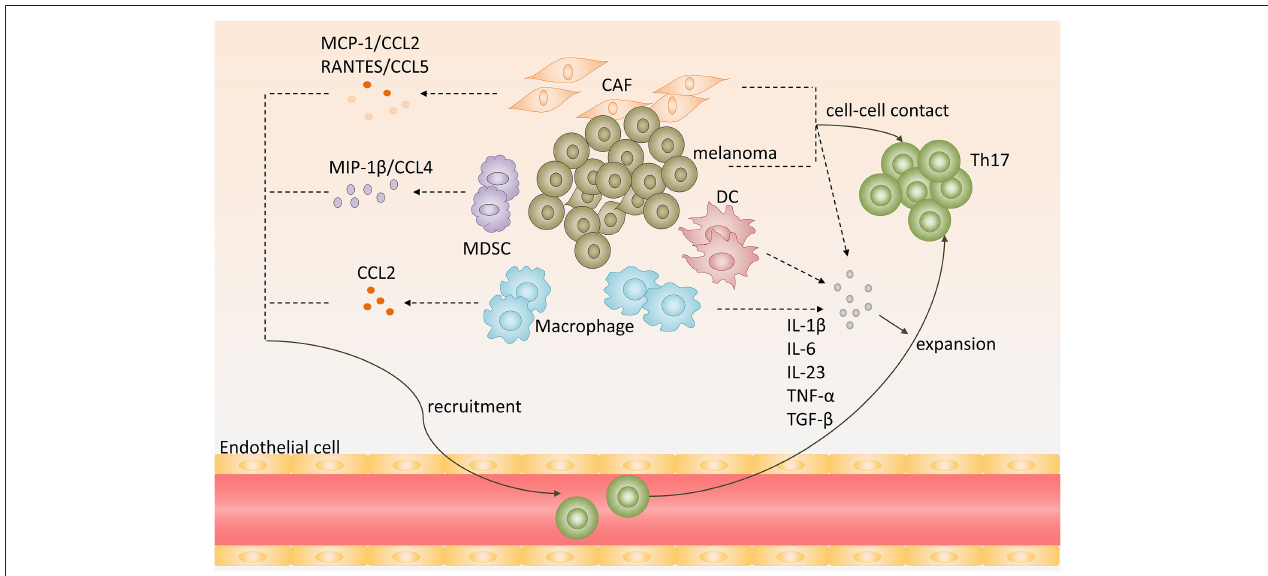
FIGURE 1 | Recruitment, expansion of Th17 cells in melanoma microenvironment. Chemokines, including CCL2, CCL5, CCL4, secreted by melanoma, cancer-associated-fibroblasts (CAF), myeloid-derived suppressor cells (MDSC) or tumor-associated macrophages (TAM), promote Th17 cells recruitment to melanoma. Melanoma cells, CAFs, TAMs, and DCs produce proinflammatory cytokines, such as IL-1 β , IL-6, IL-23, TNF- α , and TGF- β , and provide cell-cell contact that promote expansion of Th17